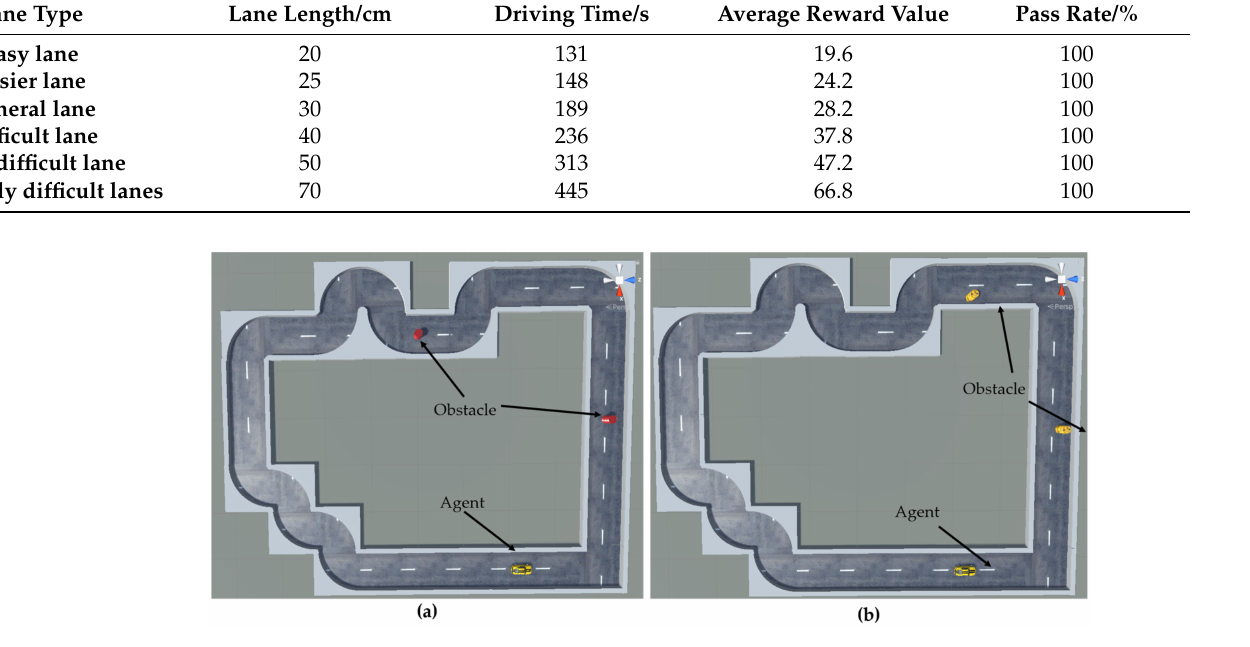
Figure 14. Autonomous driving obstacle avoidance experiments of virtual vehicles in different types of obstacle environments. ( a ) is the obstacle environment with penalty feedback, ( b ) is the obstacle environment without penalty